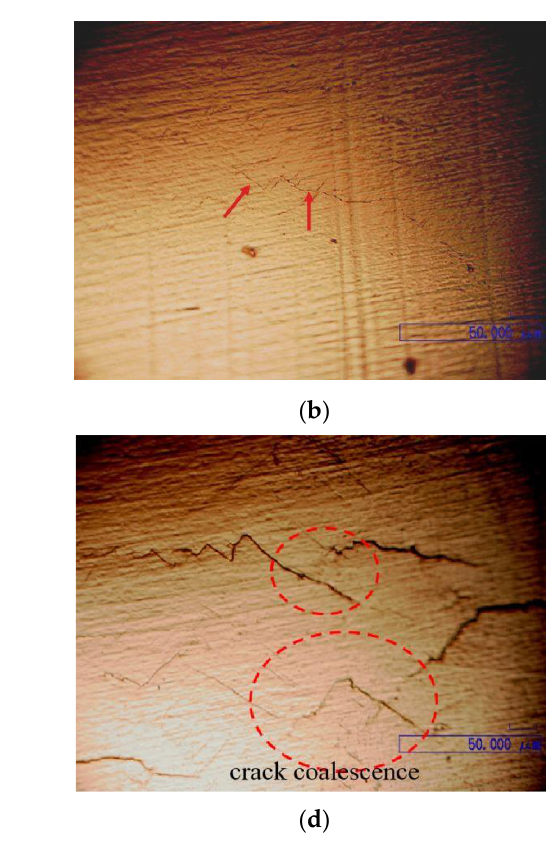
Figure 7 . Fatigue crack evolution of TC21 titanium alloy specimen under 950 MPa stress amplitude (Red arrows represent fatigue cracks; red rings represent fatigue crack coalescence). ( a ) N = 200 cycles (6% Nf ). ( b ) N = 800 cycles (23% Nf ). ( c ) N = 1400 cycles (40% Nf ). ( d ) N = 2000 cycles (57% Nf ).